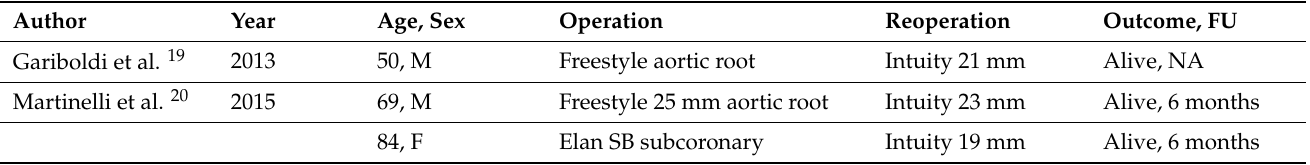
Table 2. Use the Intuity rapid deployment bioprosthesis in challenging reoperations. Summary of reported cases.